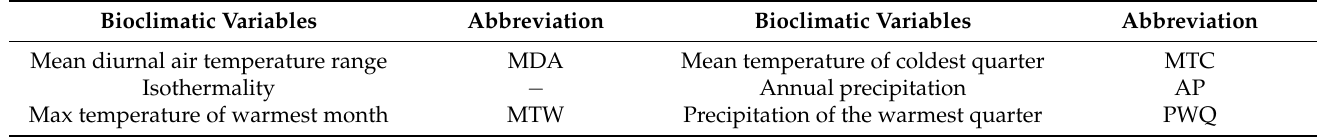
Table 1. Bioclimatic variables and their